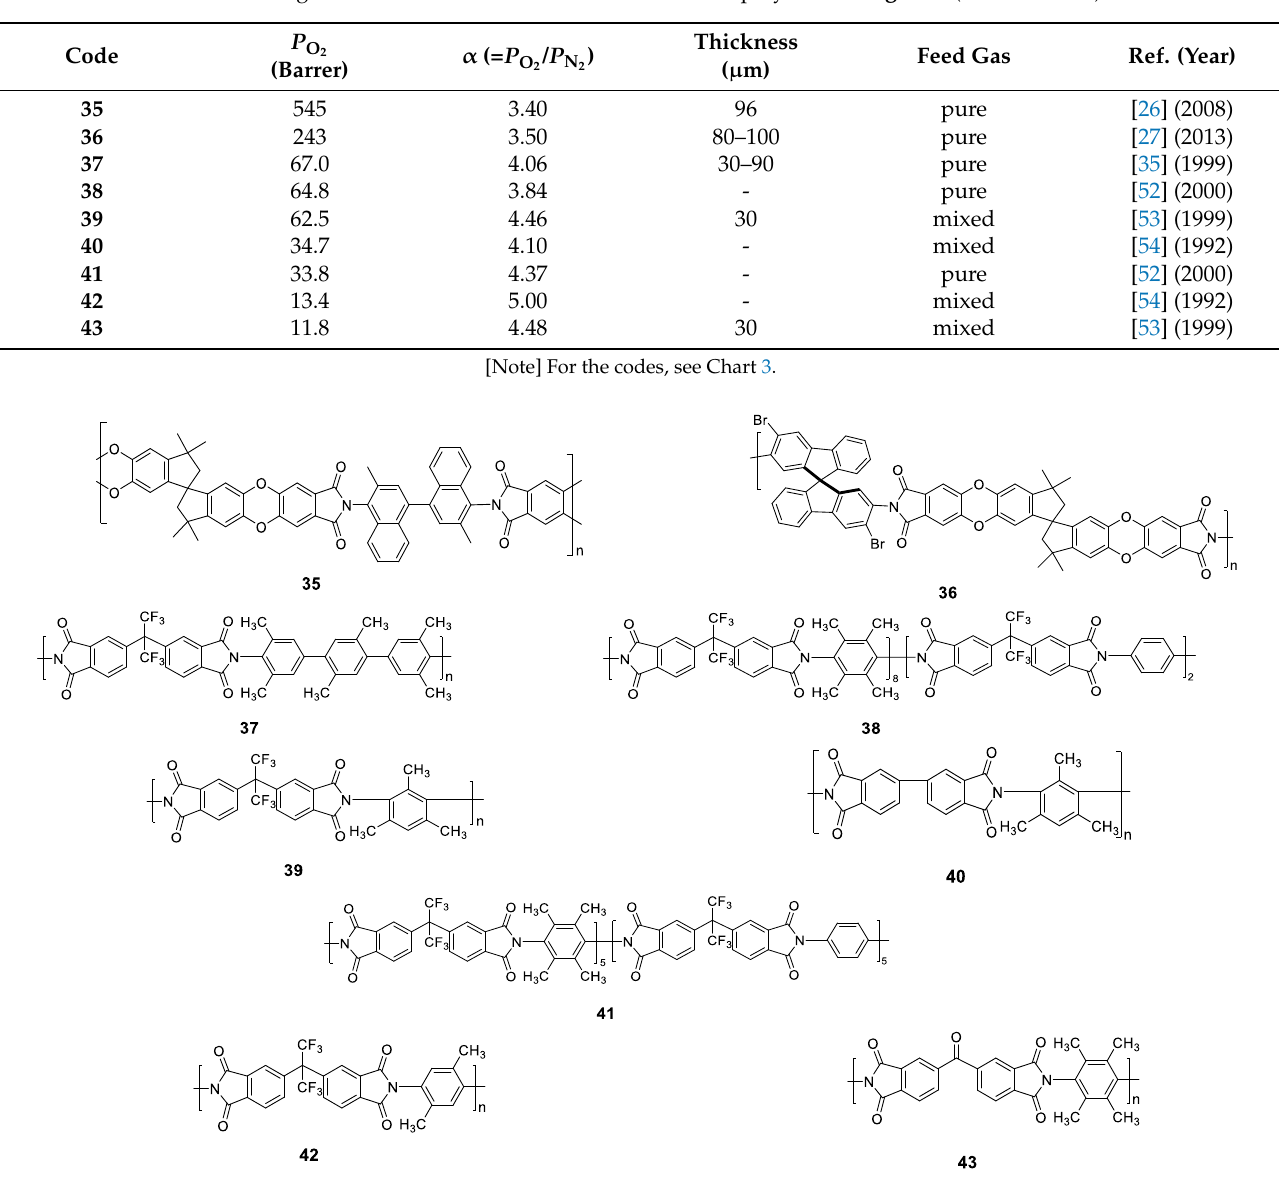
Table 3. Categorization and detail data for the membrane polymers in Figure 5 (PIs until 2013).